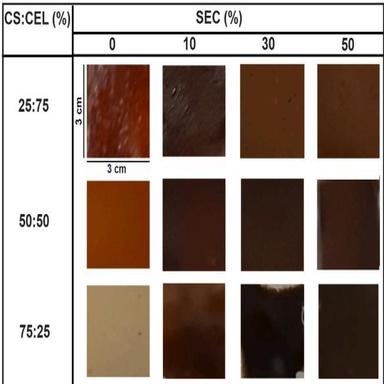
Photographs of 3 cm by 3 cm CS:CEL:SEC composites' surfaces.